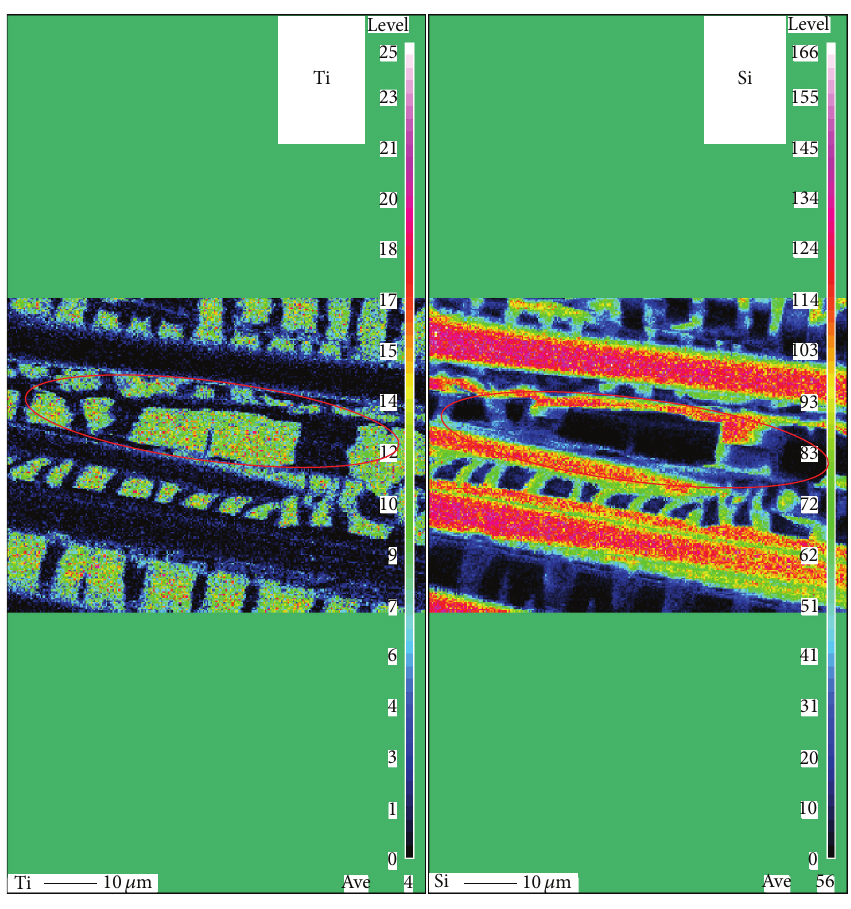
Figure 6: EPMA image of TiO 2 film coated on netlike glass disc.